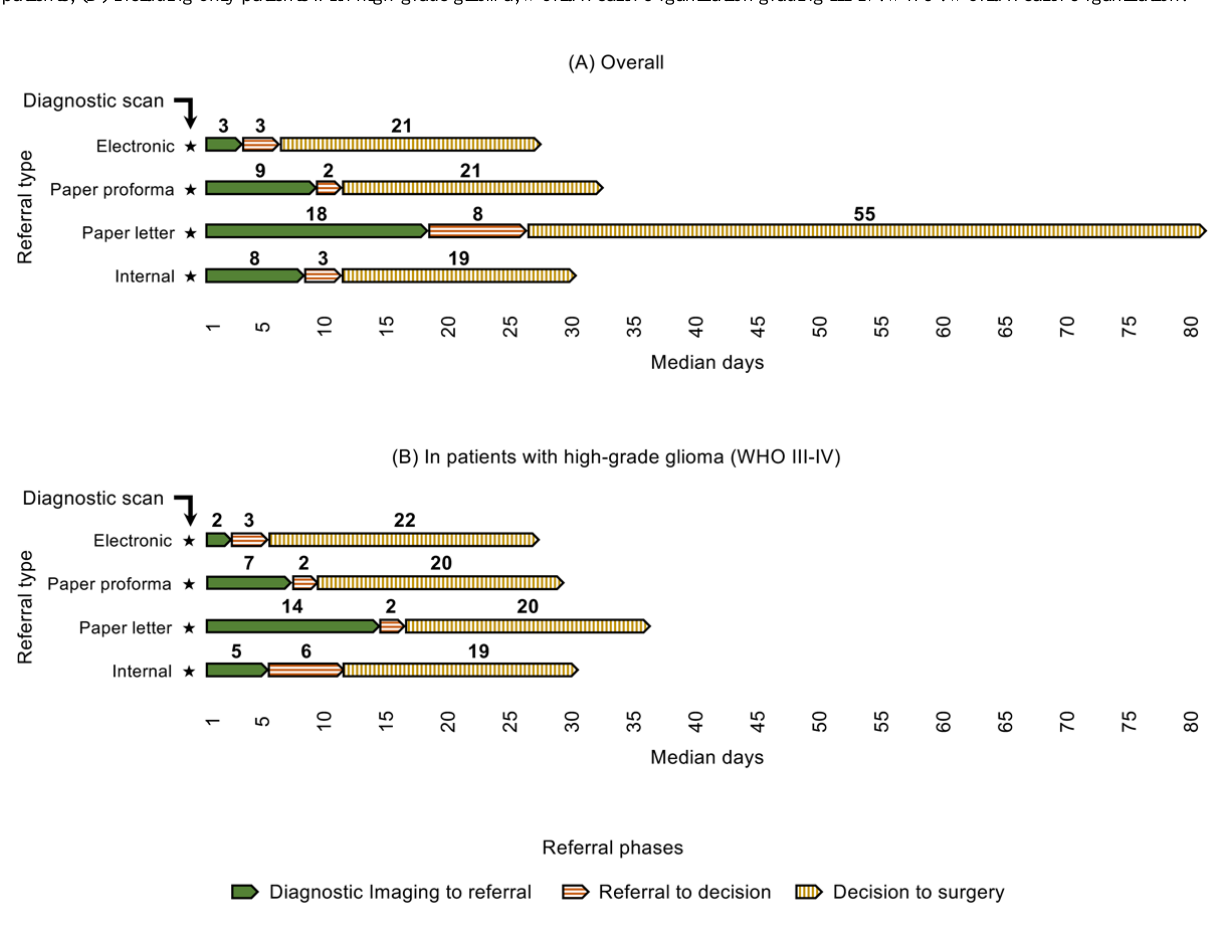
Figure 4. Median interval times of each referral phase, by referral type, during the 4 months of the study period (April and September of 2016 and 2017). Patients with nonstandard (initially done as emergency neurosurgery referrals) or unknown referral source are not plotted (n=10). (A)